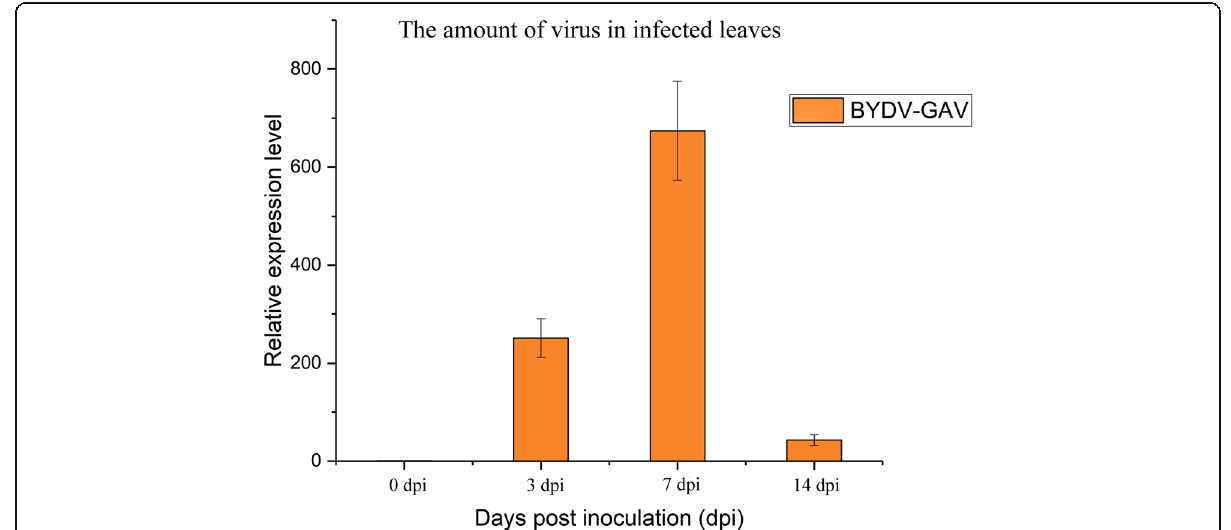
Fig. 2 The relative BYDV-GAV amount analyzed by quantitative real-time PCR in P. huashanica at different time points after inoculation with viruliferous aphids carrying BYDV-GAV. The number of aphids was 5 per